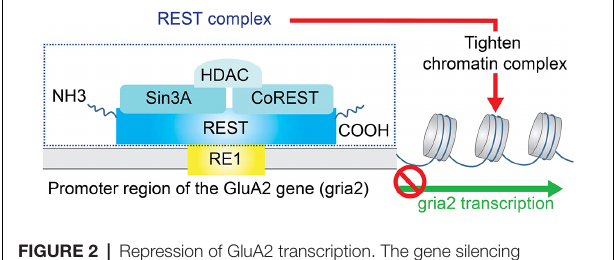
FIGURE 2 | Repression of GluA2 transcription. The gene silencing transcription factor neuronal repressor element-1 (RE1) silencing transcription factor (REST) represses the transcription of the AMPAR subunit GluA2. Specifically, REST binds the cis-acting RE1 within the promoter region of the GluA2 gene. Together with the co-repressors Sin3A and coREST which recruit histone deacetylase (HDAC), the REST complex silences GluA2 gene transcription by deacetylation of the core histone protein and tightening of the core chromatin complex. FIGURE 3 | Q/R editing of GluA2 pre-mRNA. The RNA processing